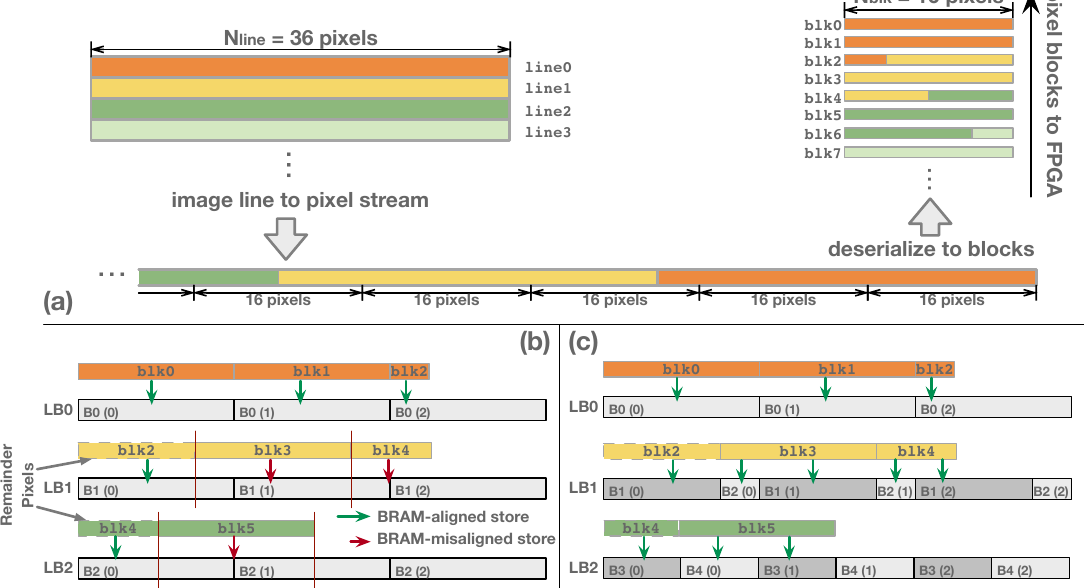
Figure 3. ( a ) Shows that the image lines are sequenced into a stream and then clipped to multi-pixel blocks; FPGA accepts one block in each cycle. ( b ) Shows the general pixel buffer in which the BRAM- misalignment issue occurs. ( c ) Shows the SWIM buffer avoids the BRAM-misalignment using specific BRAM